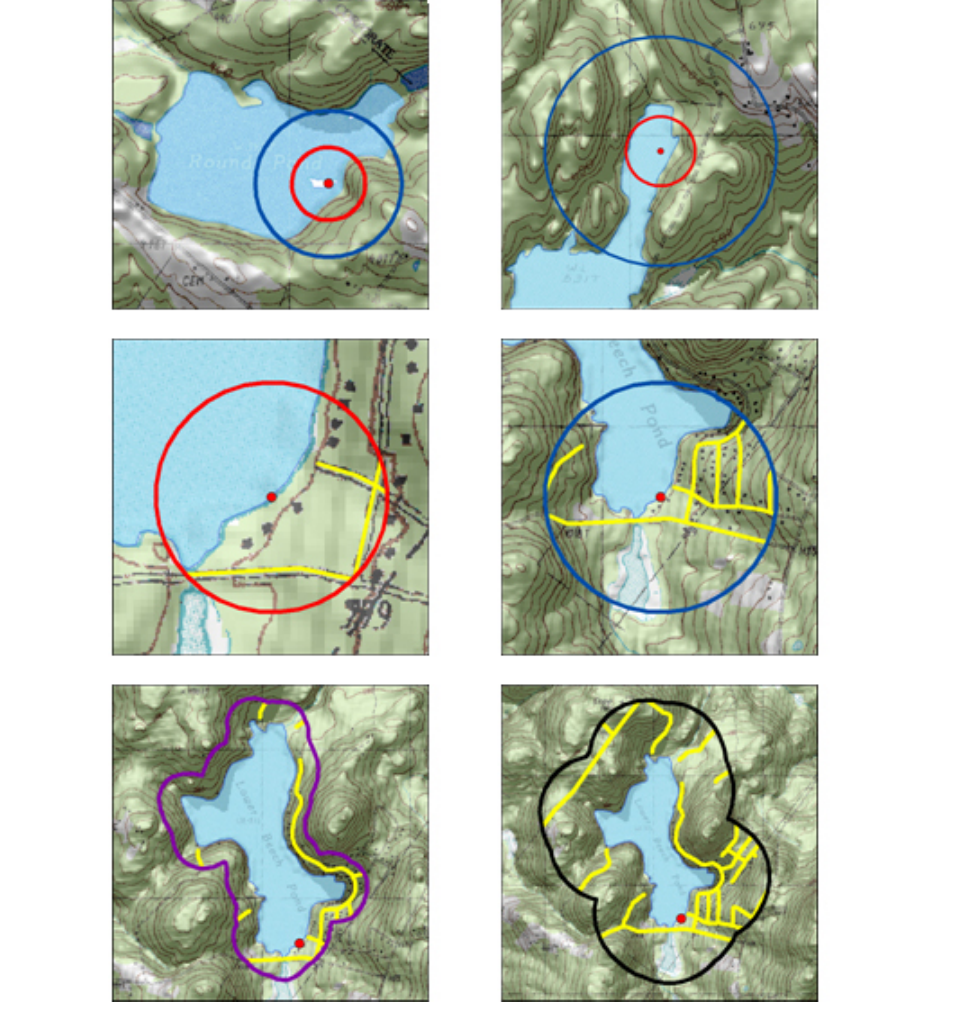
Fig. 3. Maps illustrating land cover and road density within 150- and 500-m zones of each lake and within 150- and 500-m radii of a Common Loon nest site and a randomly chosen, non-nest site. Red and blue lines represent the 150- and 500-m radii areas, respectively, surrounding each nest and non-nest site. Purple and black lines represent the 150- and 500-m zones, respectively, surrounding each